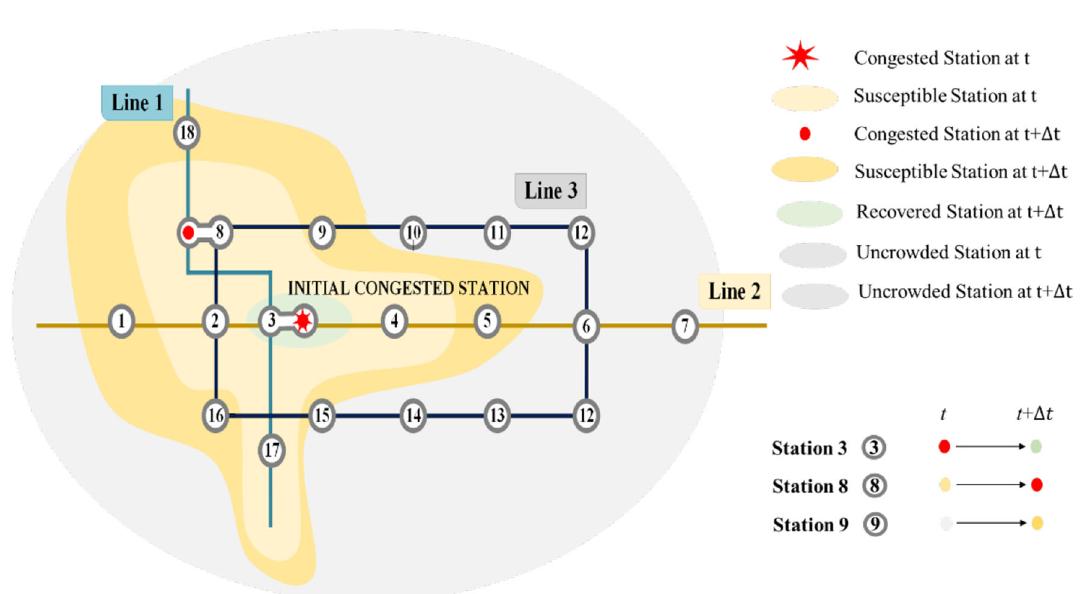
Fig. 2 Congestion propagation between t and t ? D